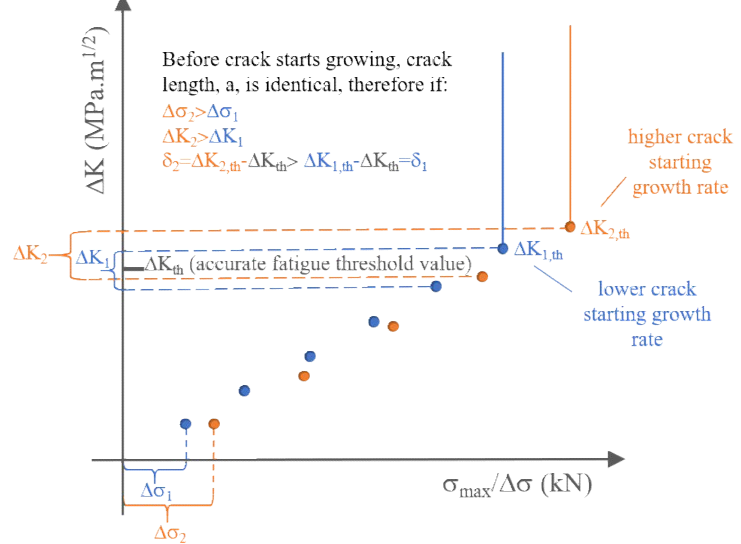
Figure 14. E ff ect of stress incremental interval on stepwise load-increasing Figure 14. Effect of stress incremental interval on stepwise load-increasing method.